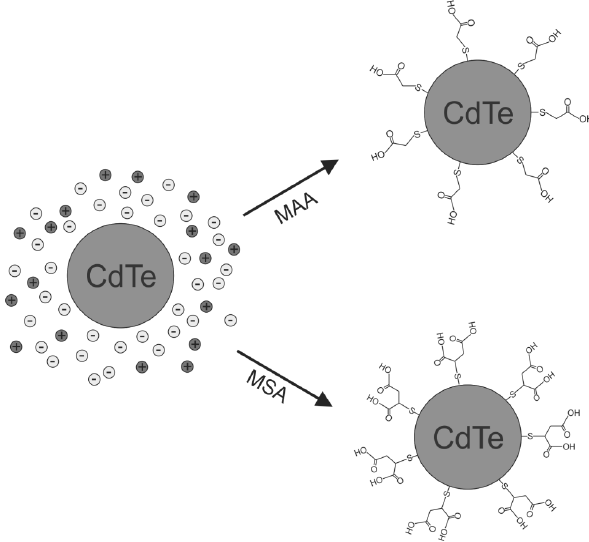
Figure 1. Method of CdTe passivation and functionalization with MAA [3], or MSA. (Adapted from Khatchadourian et al ., 2007